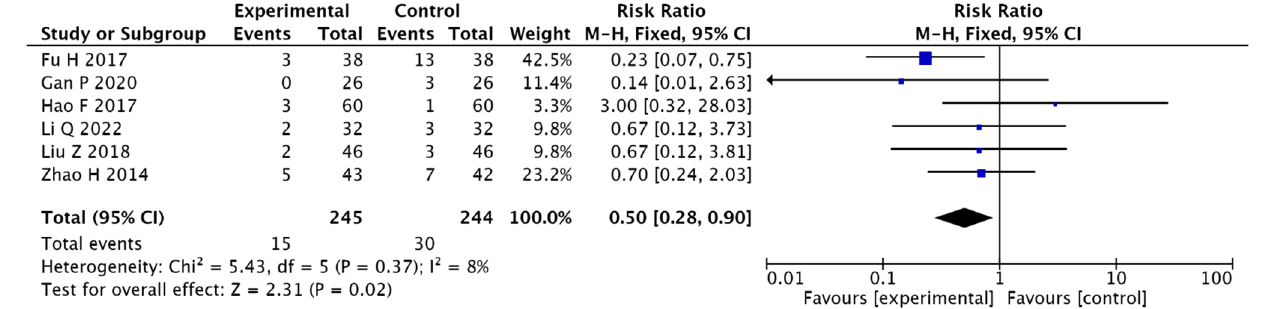
Figure 10. Forest plot of adverse reactions [13,15,19–21,28].